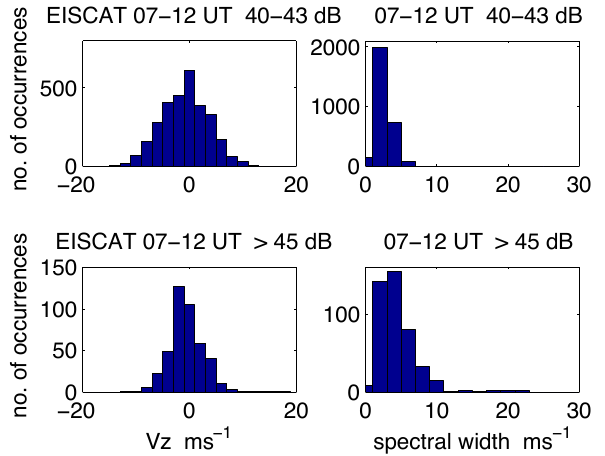
Fig. 4. Histograms showing the distribution of Doppler shifts and spectral widths for the EISCAT observations included in Fig. 2. The power interval 40–43dB is chosen to represent echoes from the background ionospheric plasma, while power > 45dB is repre- sentative of PMWE.